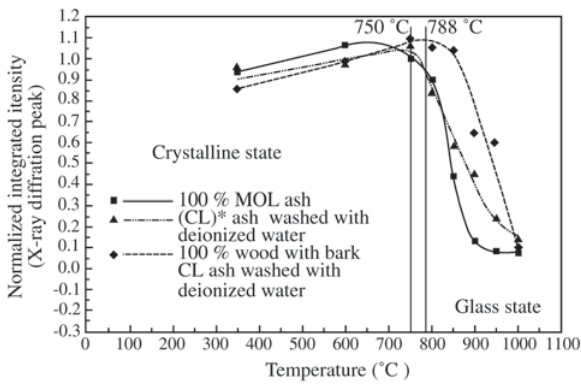
Figure 5. Normalised integrated intensity of X-ray diffraction peaks as a function of the sintering temperature of some ashes.